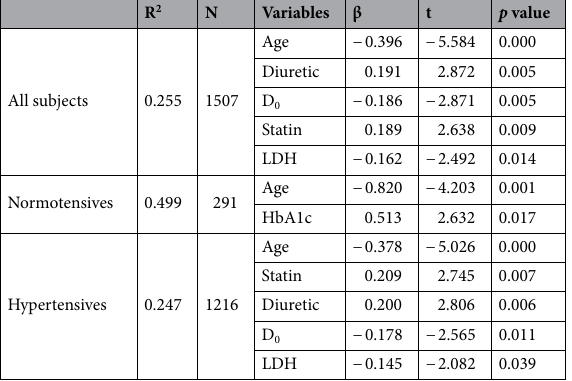
Table 3. Stepwise multiple linear regression analysis of FMD before and after stratification of hypertension. FMD flow-mediated dilation;